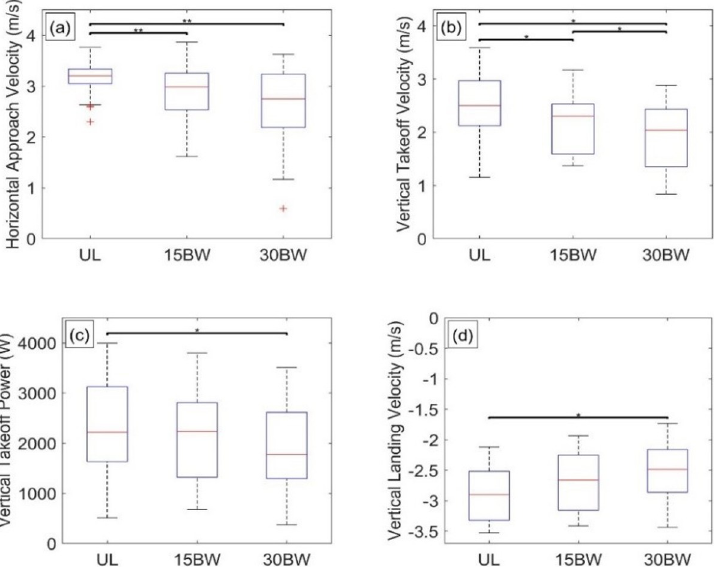
Fig 11. Wall statistical results. Boxplots depicting the results from the Tukey post hoc analysis of wall obstacle metrics for a) horizontal approach velocity, b) vertical takeoff velocity, c) vertical takeoff power and d) vertical landing velocity. The bars denote significant differences between loading conditions at a significance level α = 0.05 � , 0.01 �� , 0.001 ���